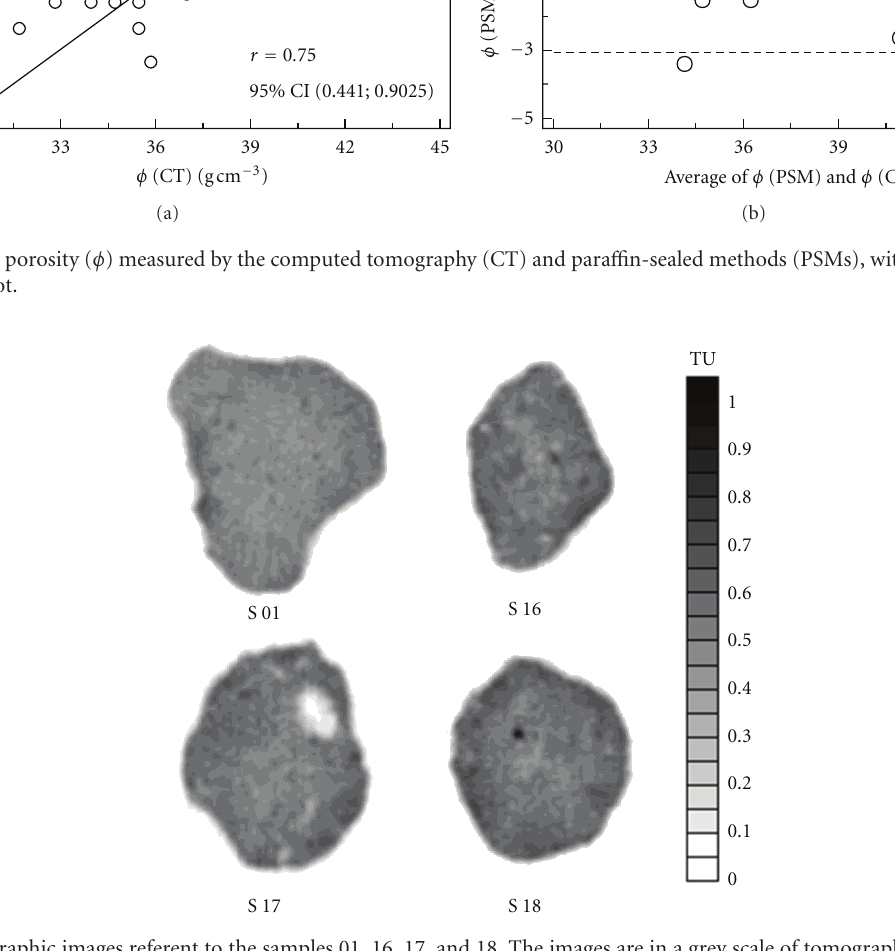
Figure 6: Tomographic images referent to the samples 01, 16, 17, and 18. The images are in a grey scale of tomographic units (TU), where the darker regions indicate the highest value of